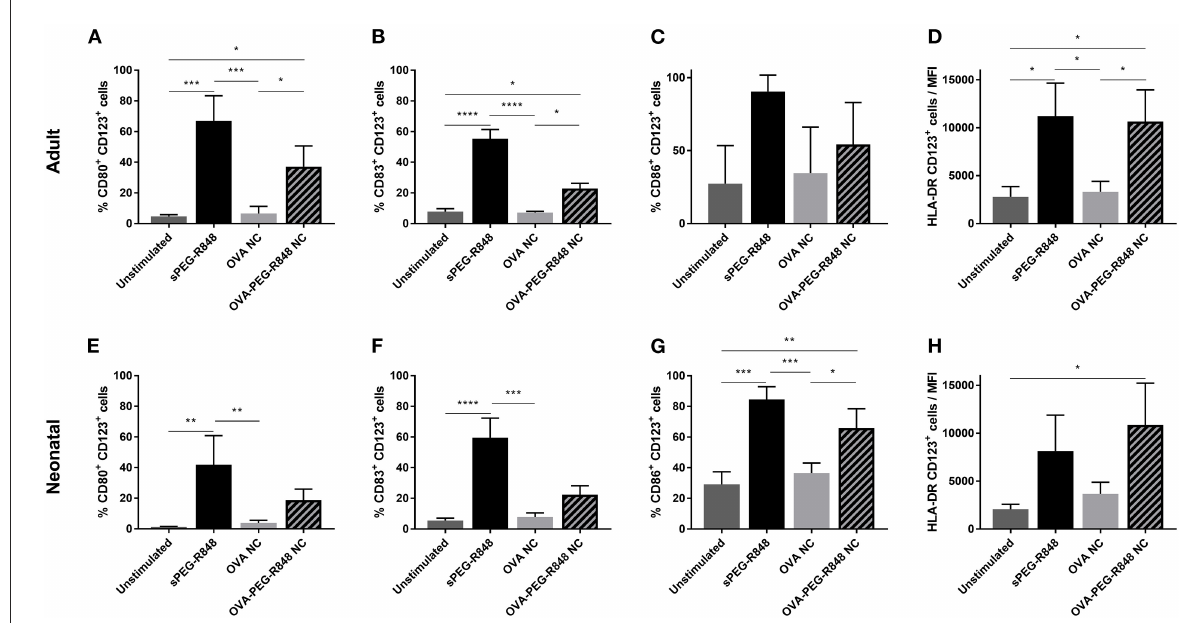
FIGURE6 Stimulation of CD123 + pDCs by OVA-PEG-R848 NCs. Flow cytometric analysis of adult (A–D) and neonatal (E–H) CD123 + DCs after incubation with soluble PEG-R848, empty OVA NCs or OVA-PEG-R848 NCs. CD80 + (A,E) , CD83 + (B,F) and CD86 + (C,G) cells, and HLA-DR mean fluorescent intensity (D,H) were evaluated. Data represent the means ± SD ( n = 3). Significantly different: * P < 0.05; ** P < 0.01; *** P < 0.005; **** P < 0.0001 (one-way